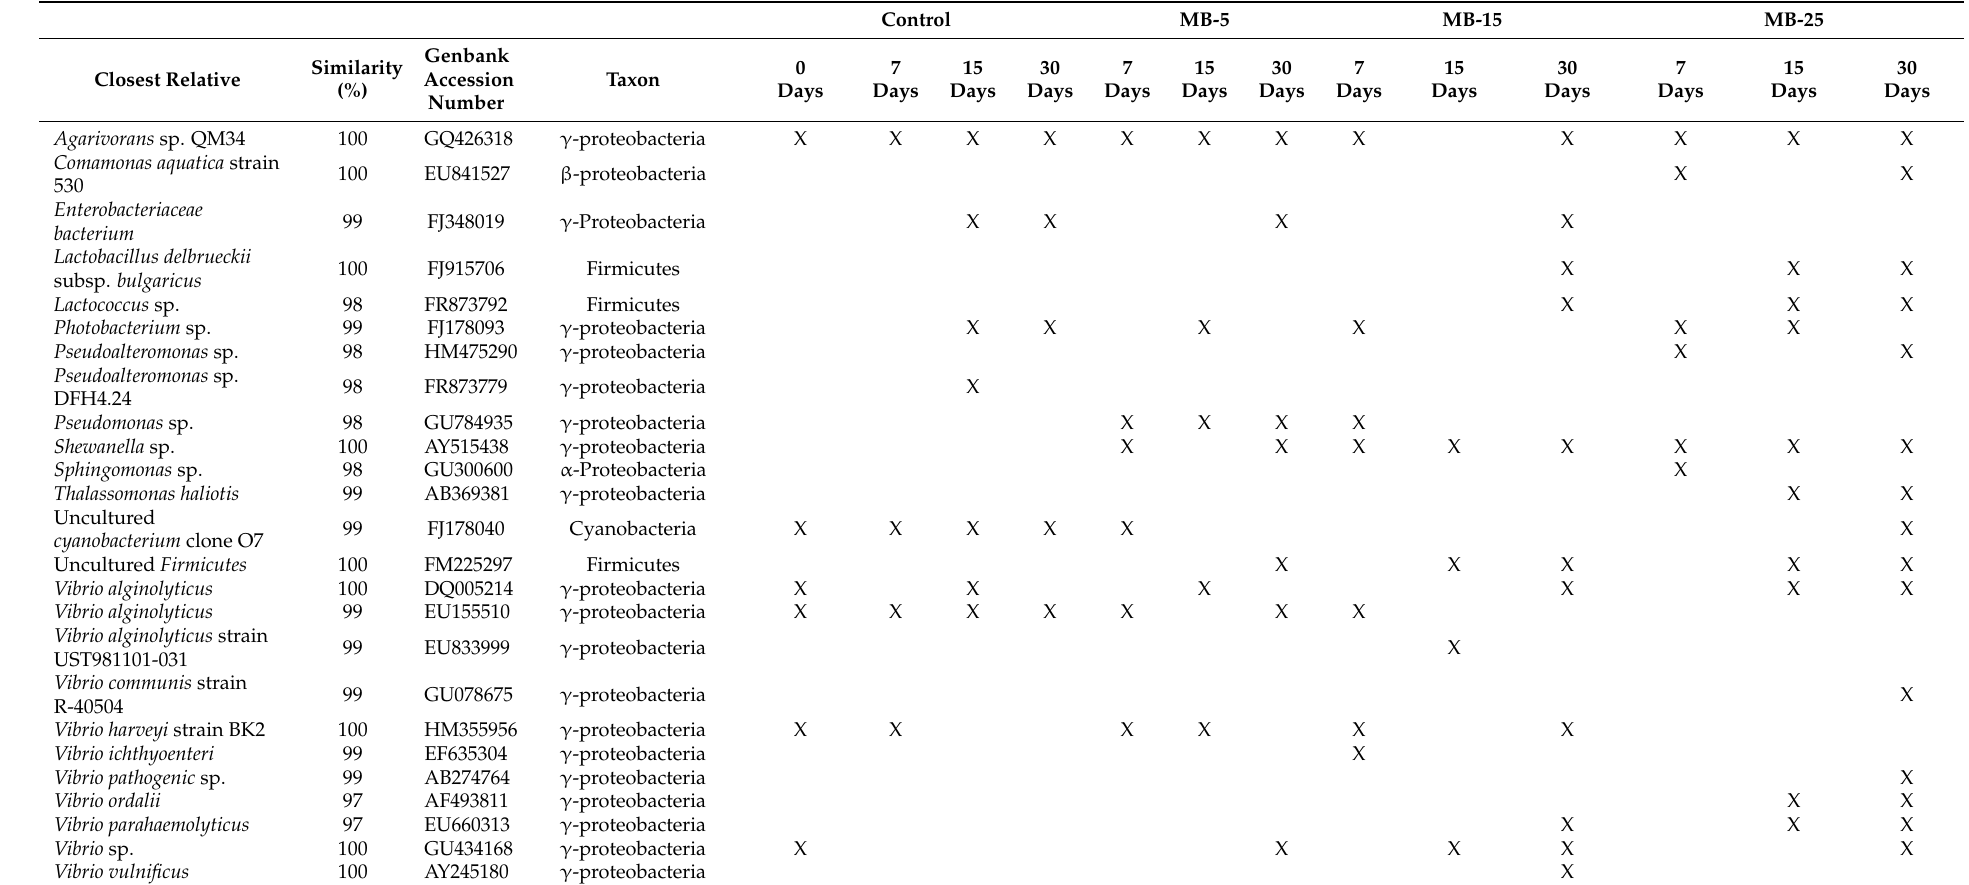
Table 8. 16S rDNA sequence similarities to closest relatives of DNA recovered from the respective predominant bands in the DGGE gel corresponding to juvenile S. aurata fed experimental diets for 30